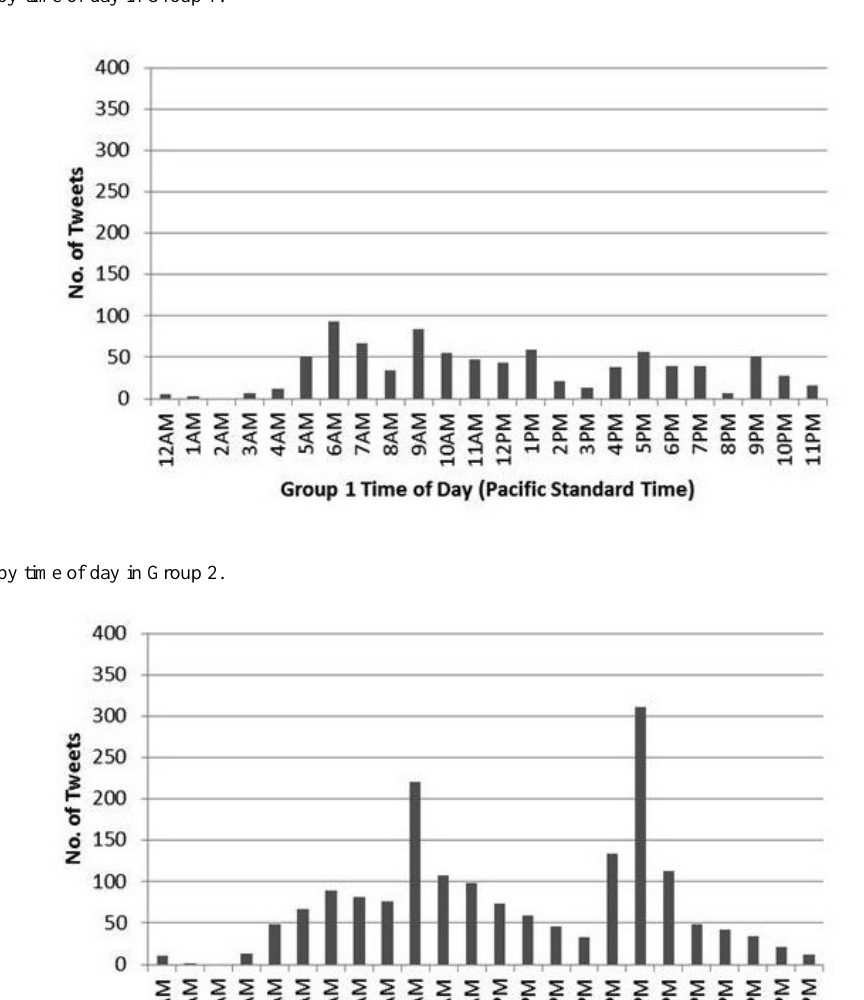
Figure 3. Tweeting by time of day in Group 1.